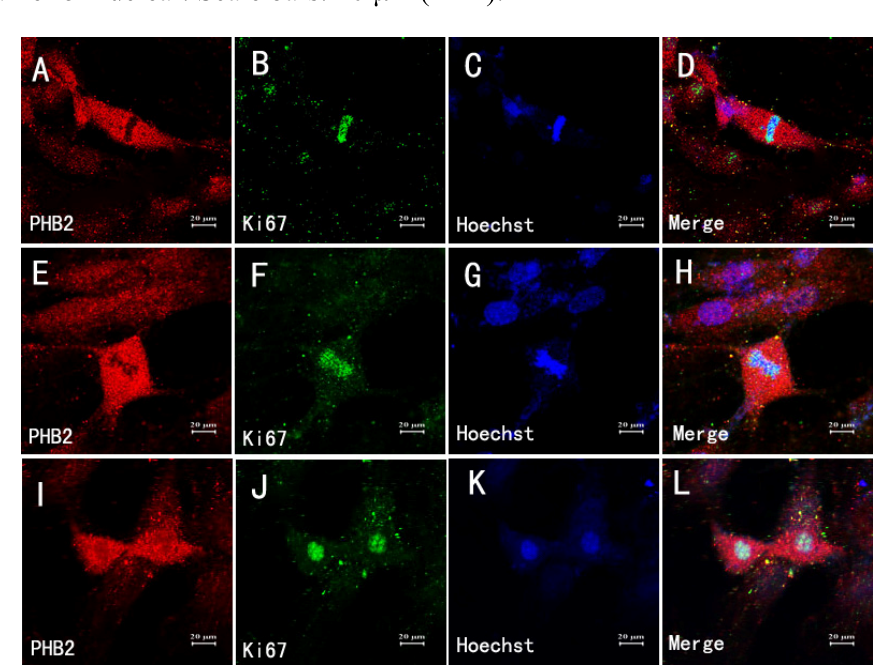
Figure 6. The relationship between astrocytes mitosis and PHB2. Fluorescent double labeling demonstrates: Cells at late metaphase showed high expression level state of PHB2 ( A , E , I ); PHB2 and Ki67 (marker of cell proliferation) ( B , F , J ) double-fluorescent